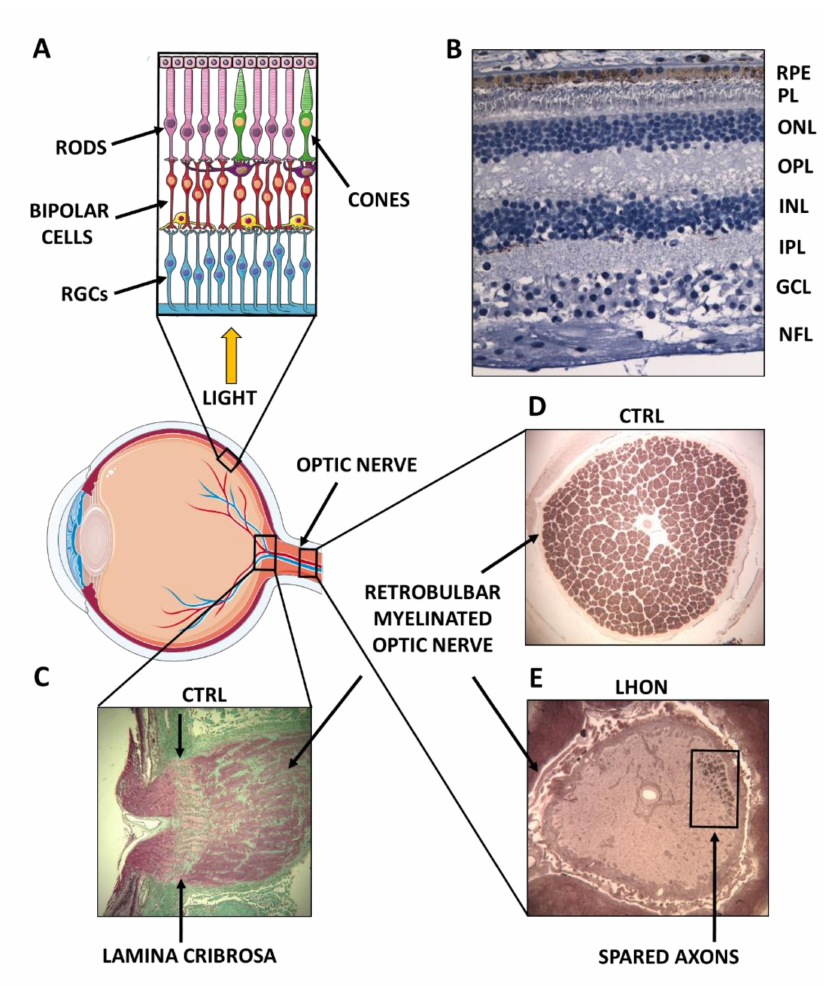
Figure 1. Anatomy of the human retina and optic nerve. ( A ) Graphical illustration of the eye, with the retina and the optic nerve highlighted. The three key retinal cell types implicated in the visual processing are indicated: photoreceptors (rods and cones), bipolar cells, and ganglion cells (RGCs). The pigment epithelium juxtaposed to photoreceptors, horizontal (purple) and amacrine (yellow) cells are also shown. ( B ) Histological cross-section of a normal human retina. The layers constituting the retinal tissue are indicated: retinal pigment epithelium (RPE), photoreceptors layer (PL), outer nuclear layer (ONL), outer plexiform layer (OPL), inner nuclear layer (INL), inner plexiform layer (IPL), ganglion cell layer (GCL), and nerve fiber layer (NFL). ( C ) Histological sagittal section of a normal optic nerve head (post-mortem). The lamina cribrosa, where unmyelinated axonal bundles are organized, is indicated, as well as the post-laminar retrobulbar myelinated optic nerve. ( D ) Histological cross-section of a normal optic nerve (post-mortem) is shown with myelinated